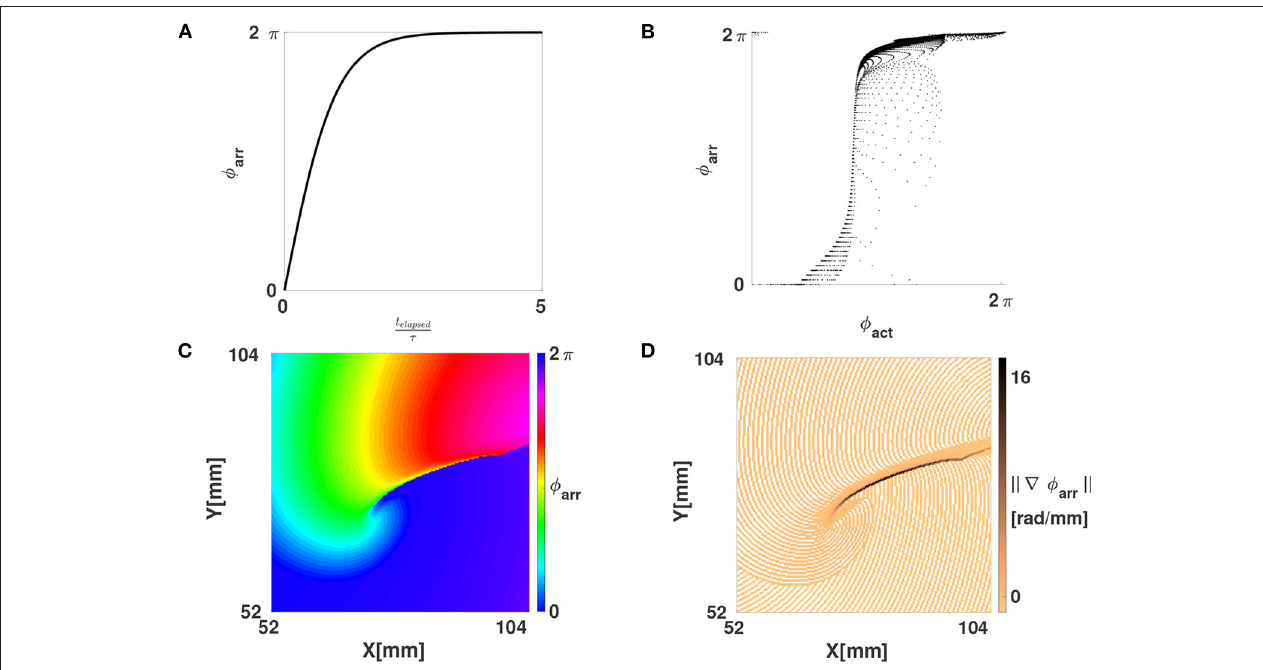
FIGURE 6 | Phase defects shown using the LAT-based phase φ arr . (A) The function φ arr ( t elapsed ) from Equation (11). (B) Scatter plot of φ arr vs. φ act , showing that one is a reparameterization of the other on the interval [0,2 π ]. (C) Same linear-core rotor in the FK model as in Figure 2B , now shown with φ arr . Note that WF and WB are no longer showing abrupt phase variations, these only happen at the PDL, i.e., the points where conduction block happened. (D) Magnitude of the gradient of φ arr . Due to the discrete sampling of LAT, a staircase artefact in the gradient is seen (no smoothing was applied